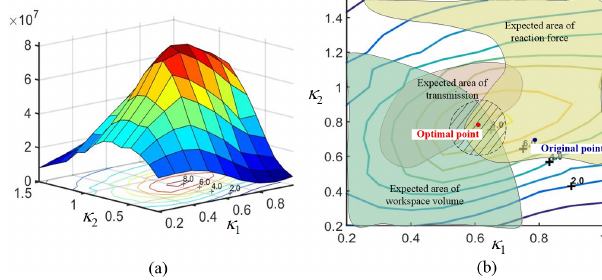
Figure 19. (cid:50) with respect to κ 1 and κ 2 : (a) surface, (b) contour map.